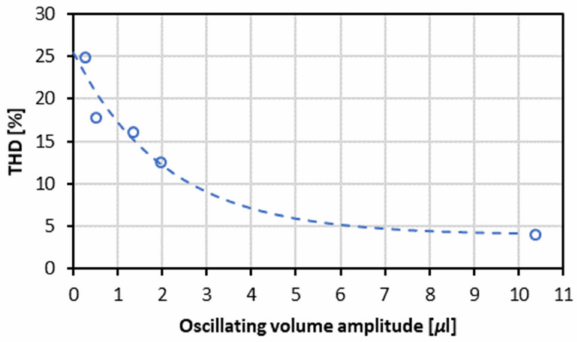
Figure 8. Experimental relation of interfacial area-based Total Harmonic Distortion ( THD IA ) to oscillation volume